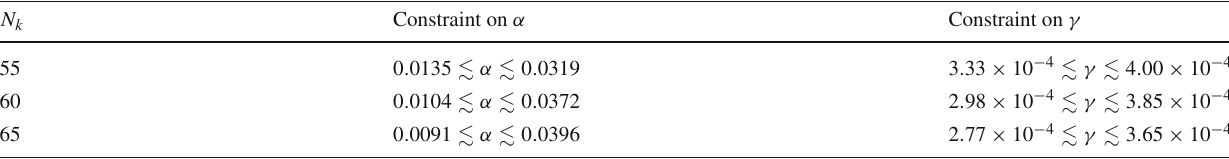
results using M 5 = 10 5 TeV while the bottom table shows the